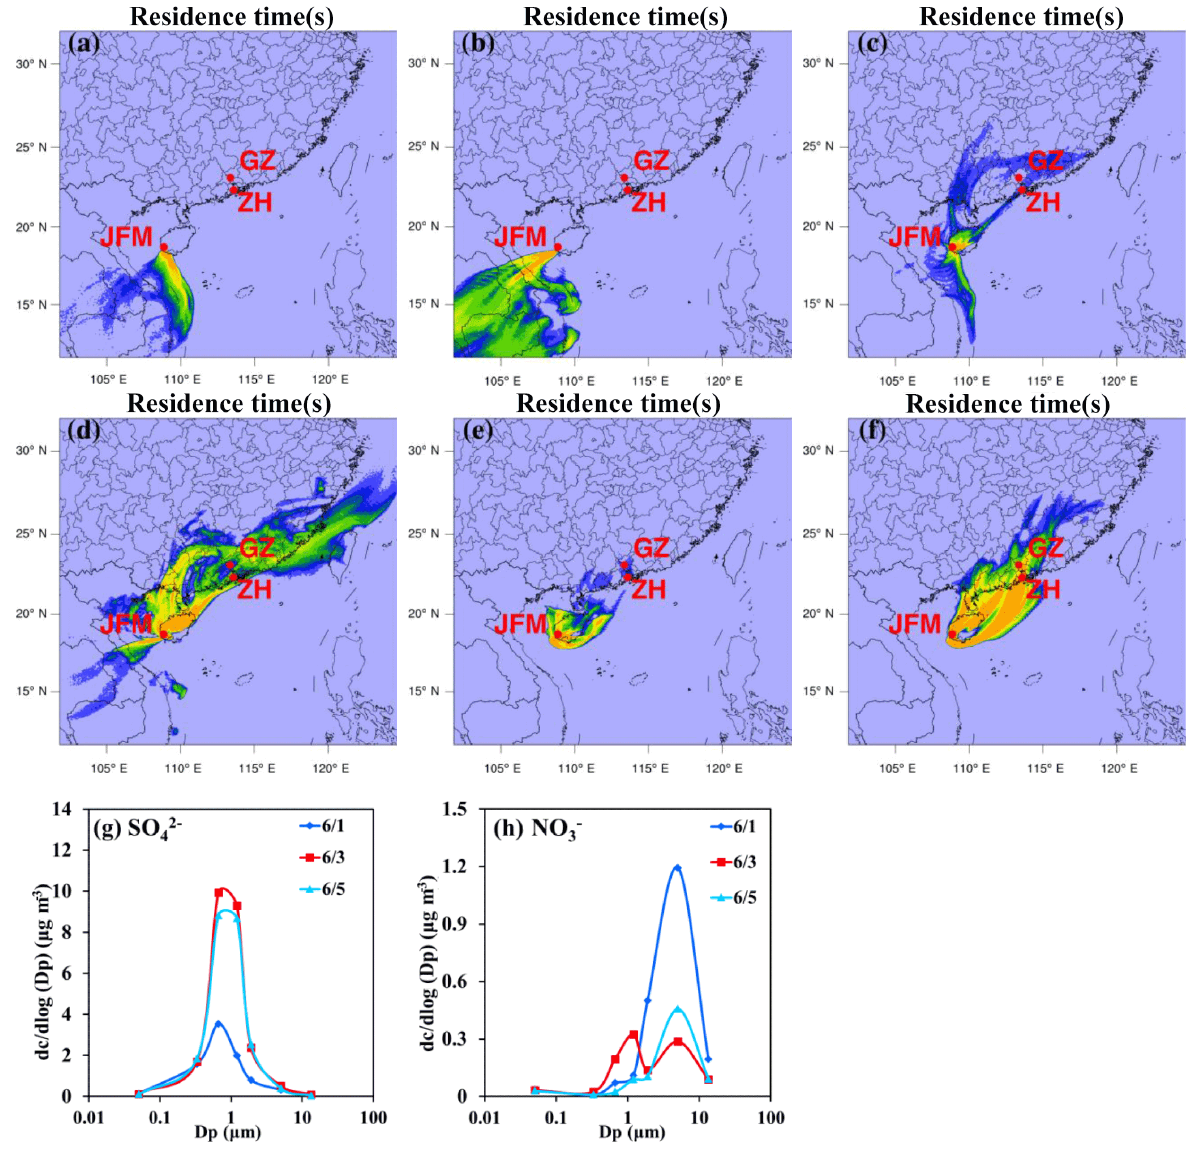
Figure 7. Case study on 1, 3, and 5 June in JFM. (a–b) FLEXPART–WRF total column residence times over the last 72h, arriving in JFM on 1 June at 100 and 1000m. (c–d and e–f) Same as (a–b) but on 3 and 5 June, respectively. (g–h) The mass size distribution of SO 2 − NO − . The colorbar for (a) – (f) is the same as that for Fig. 3